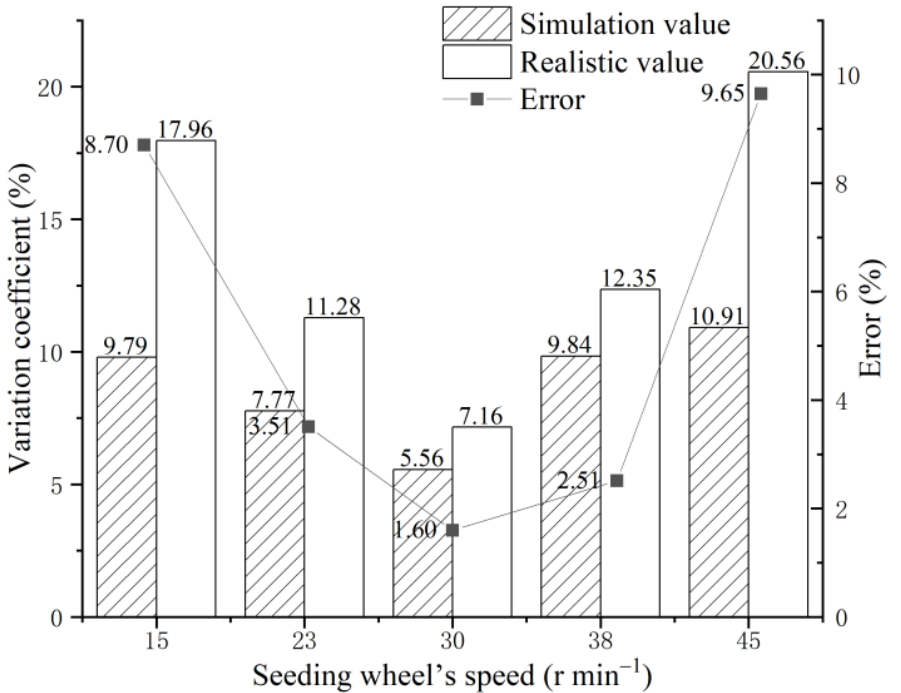
Figure 7. Clam seeding verification